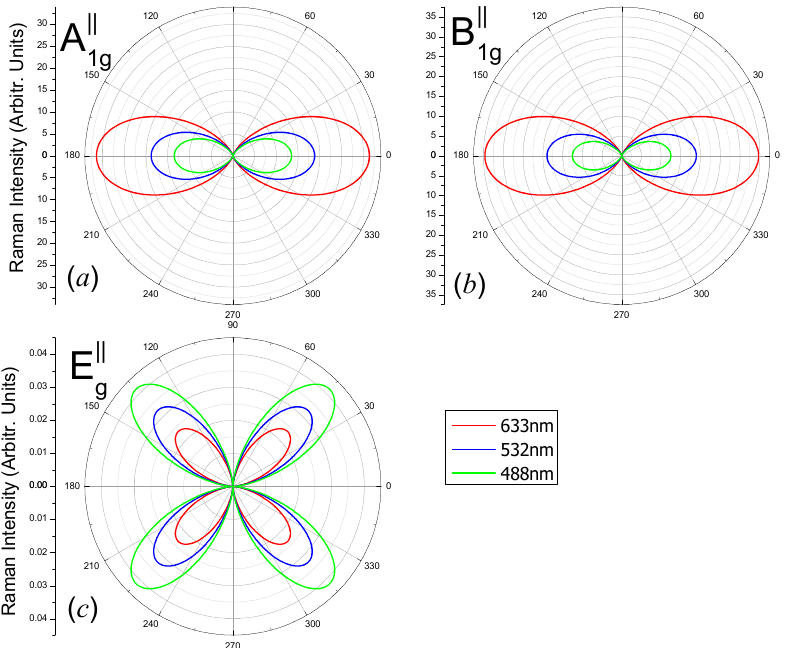
(cid:2870) ↔ 2 (cid:42) (cid:42) of ( a ) A 1g ‐ 1734 e s · R · e i | of ( a ) A 1g -1734 cm − 1 ,